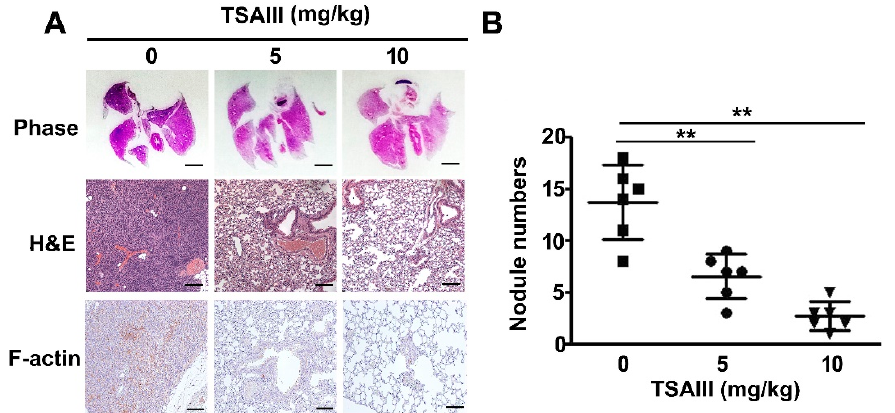
Figure 6. In vivo metastasis of TSAIII in human osteosarcoma cells. For the animal assay of lung metastasis, human osteosarcoma cells were harvested and injected into the tail veins of five-week- old immunodeficient mice (C.B17/IcrPrkdcscid/CrlNarl). The mice were then fed TSAIII (5 and 10 mg/kg) through oral gavage. After two months, the mice were euthanised and ( A ) the histopathol- ogy of the lungs in metastatic tumour-bearing animals was analysed. The lungs were fixed in neutral-buffered formalin and stained with haematoxylin and eosin. The F-actin expression were detected with immunohistochemistry assay. ( B ) The nodule numbers were then counted in the mice. ** p < 0.01 versus control ( n = 5). Scale bar: 100 μ m.